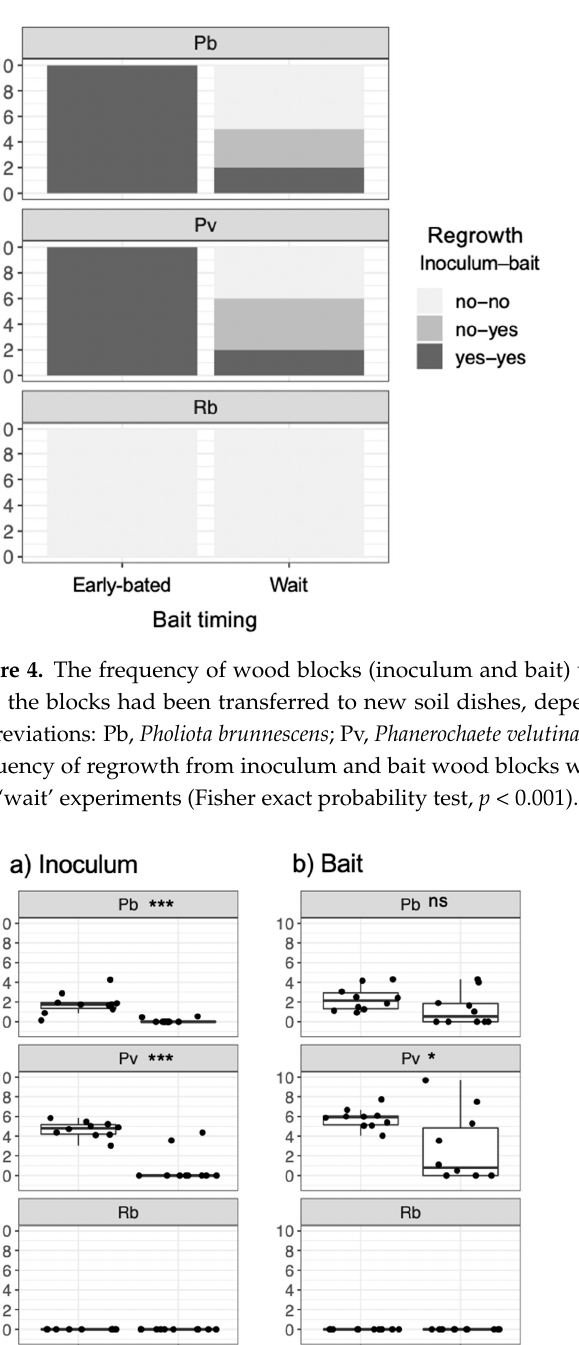
Figure 6. Bait-side hyphal coverage ratio against the whole mycelium coverage (bait-side + oppo- site side) of ( a ) inoculum and ( b ) bait wood blocks. Abbreviations: Pb, Pholiota brunnescens ; Pv,